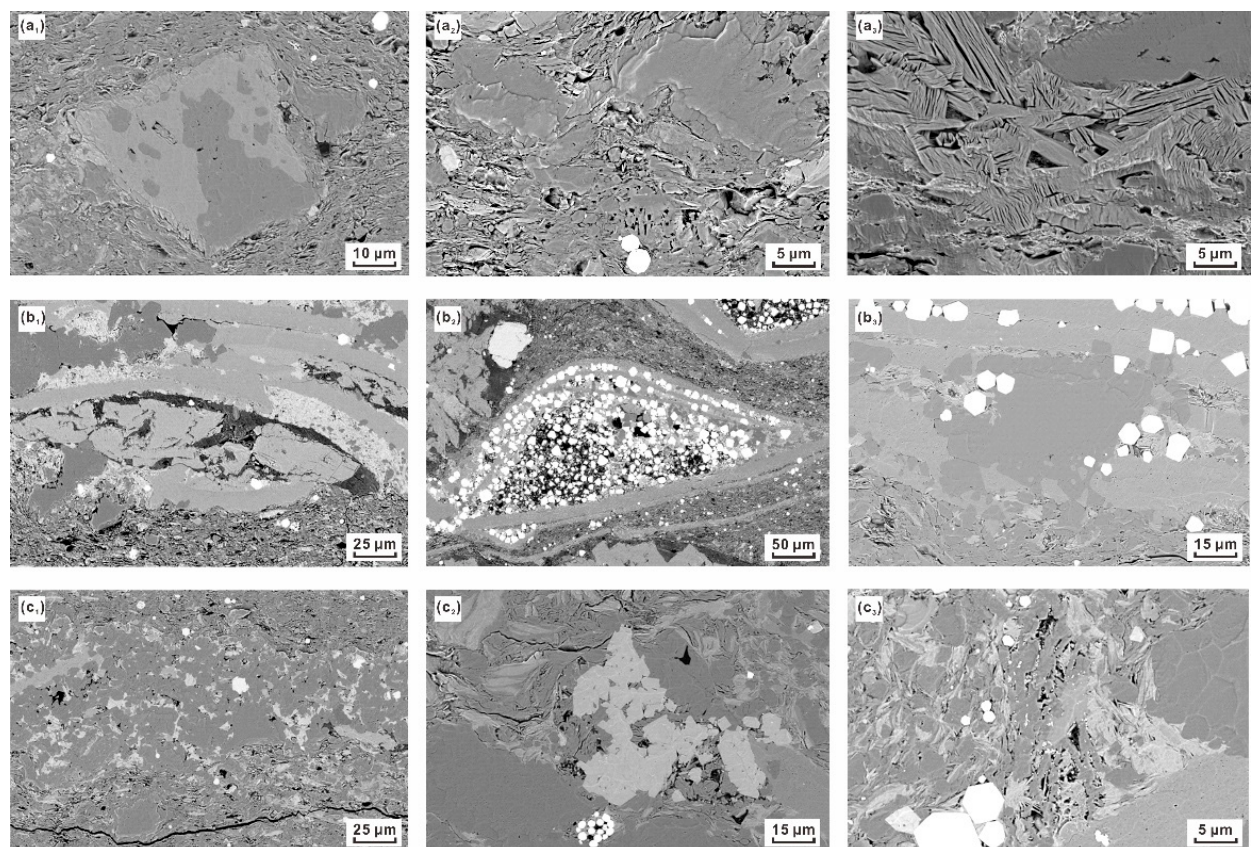
Figure 3. Mineral type and composition of different laminar units.